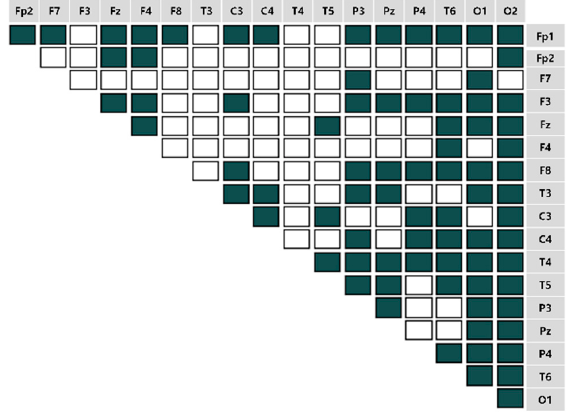
Figure 7. The brain connectivity map in the pleasant-aroused condition.